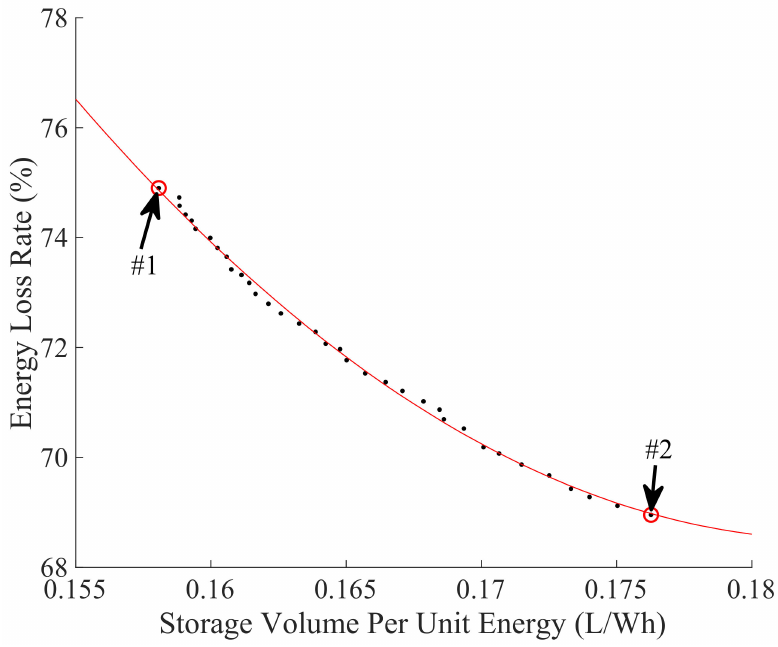
Figure 18. Pareto optimal solution at 0 ◦ C. Table 3. Two schemes on the Pareto